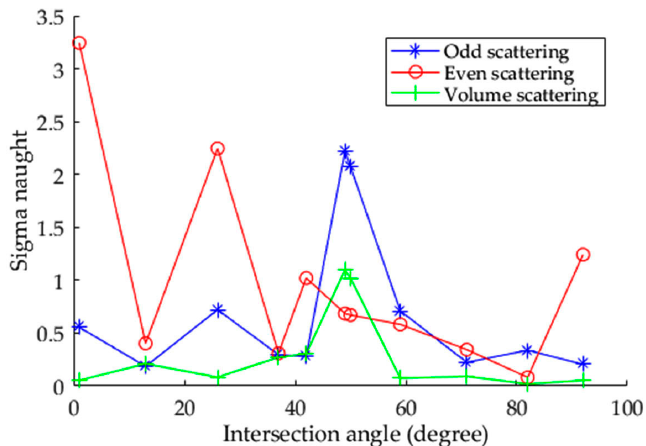
Figure 10. Each decomposed Pauli component of larger trucks oscillates with increasing intersection angle in experiment II.